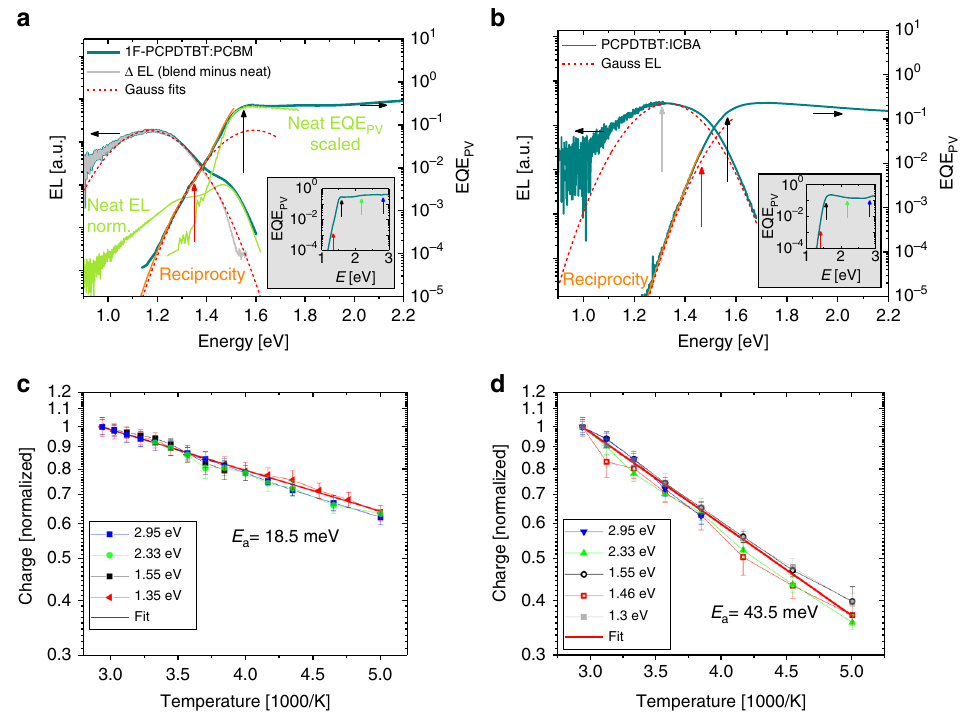
Fig. 4 Charge generation as function of temperature and excitation energy: EL and EQE spectra of a the fl uorinated 1F-PCPDTBT blended with PCBM and b the non- fl uorinated PCPDTBT blended with ICBA. Also shown are the EQE and EL spectra of neat 1F-PCPDTBT, which are assigned to the polymer singlet exciton (light-green line). The gray lines show the blend EL corrected for the polymer emission. Red dashed lines show Gaussian fi ts to the low energy emission and EQE, revealing CT energies of 1.38 eV (1F-PCPDTBT:PCBM) and 1.52 eV (PCPDTBT:ICBA). Arrows in the gray inset indicate the excitation energies. Temperature dependence of the photogenerated charges in the low fi eld plateau region for excitation below, at, and well above the polymer bandgap for c 1F-PCPDTBT:PCBM and d